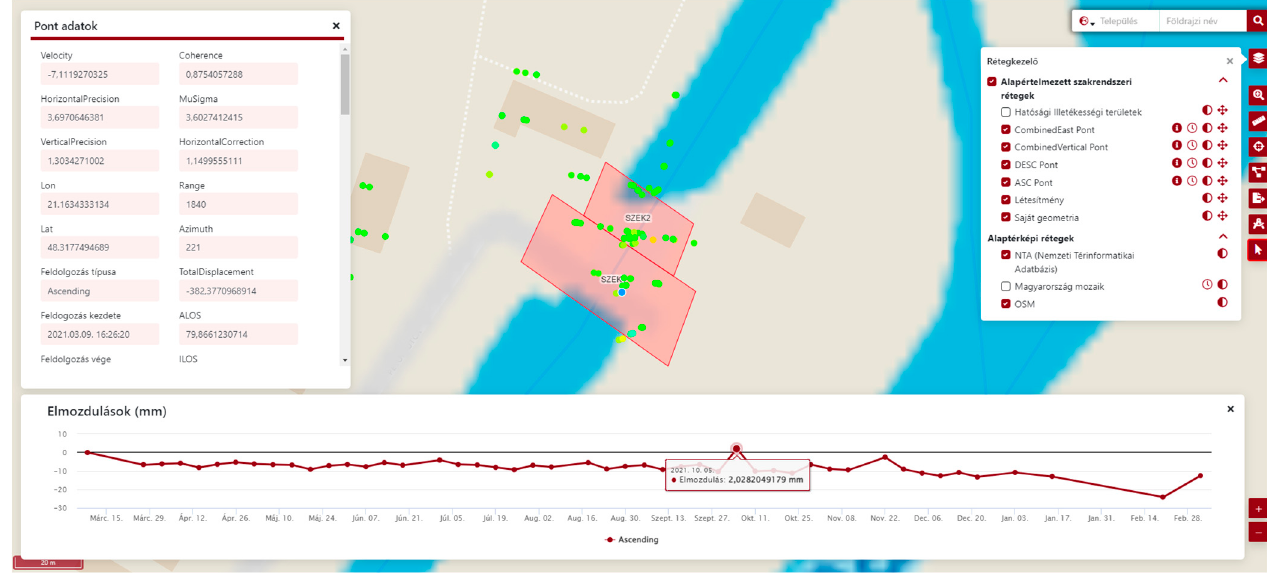
Figure 11. Interactive user interface, with the objects of a water facility and their PSs. The time series and quality measures of the chosen PS are highlighted on the left side and bottom of the figure. The layer handling toolbox is on the right side of the figure. The displayed PS points are mostly stable (green color), while some shows a slight displacement towards the sensor (yellow color). Please note, that this interface is in Hungarian, so the decimal separators are commas, not periods.